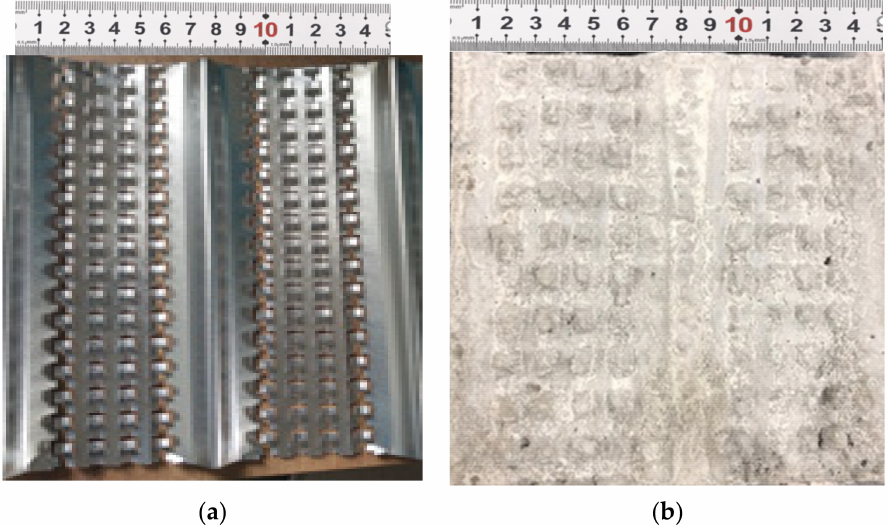
Figure 2. The third interface: ( a ) fast-ribbed closing net cut to be 150 mm × 150 mm when used for interface; ( b ) rough surface in sectional dimension of 150 mm × 150